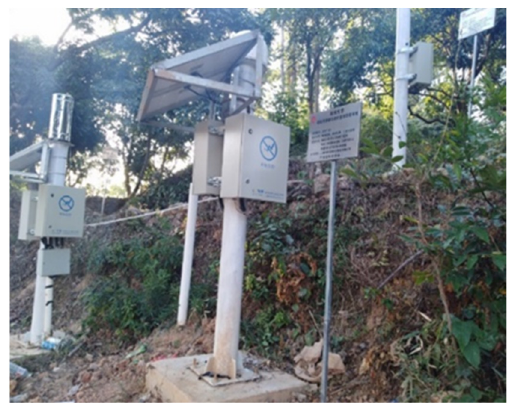
Figure 5. Location of the monitoring site.